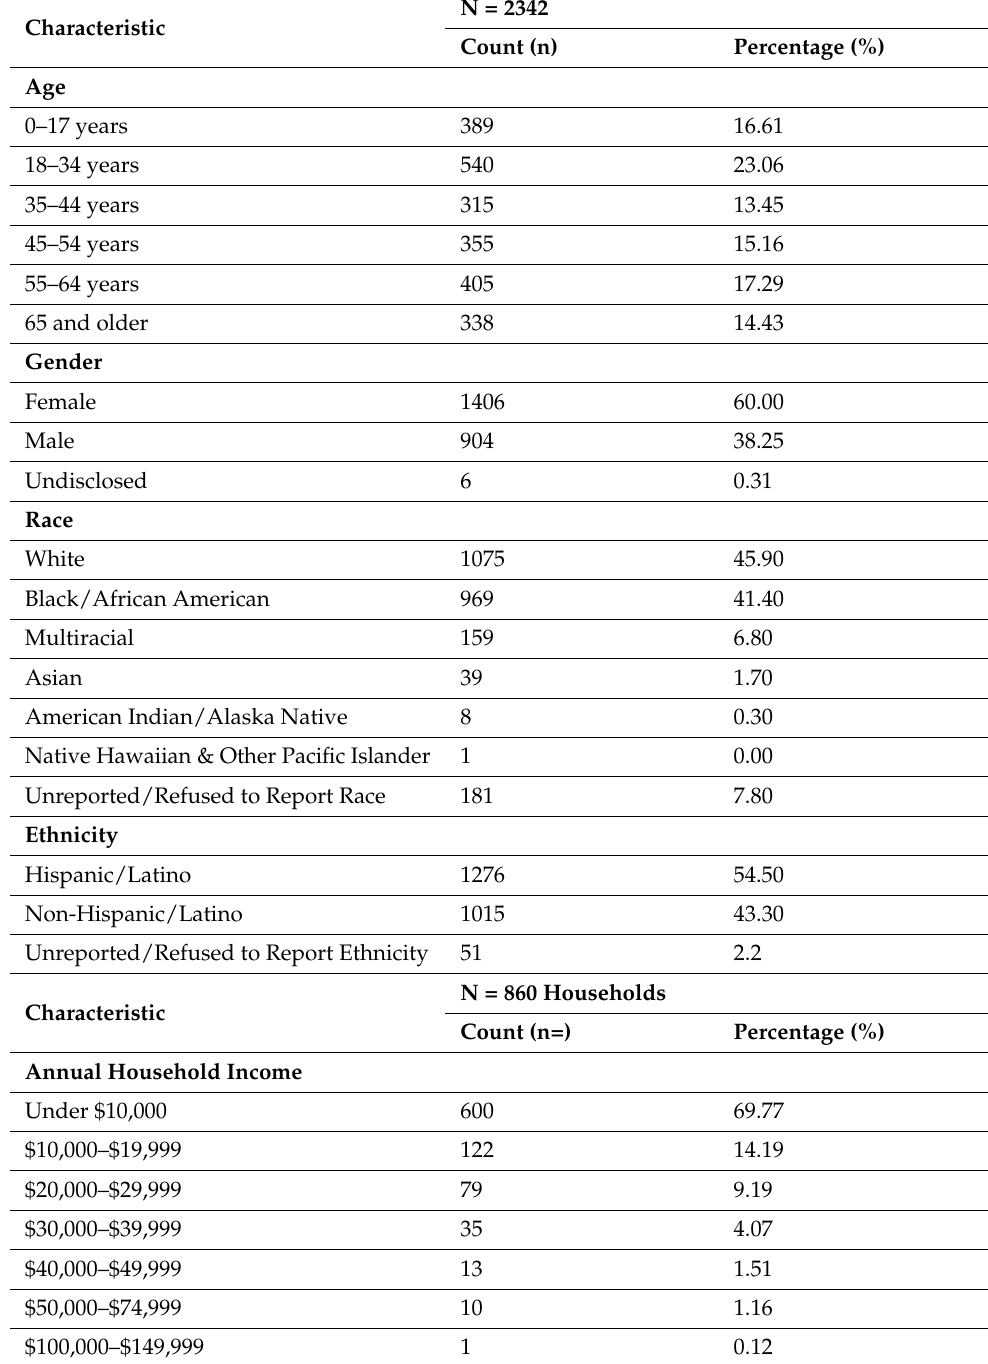
Table 1. Demographic Distribution of NeighborhoodHELP Household